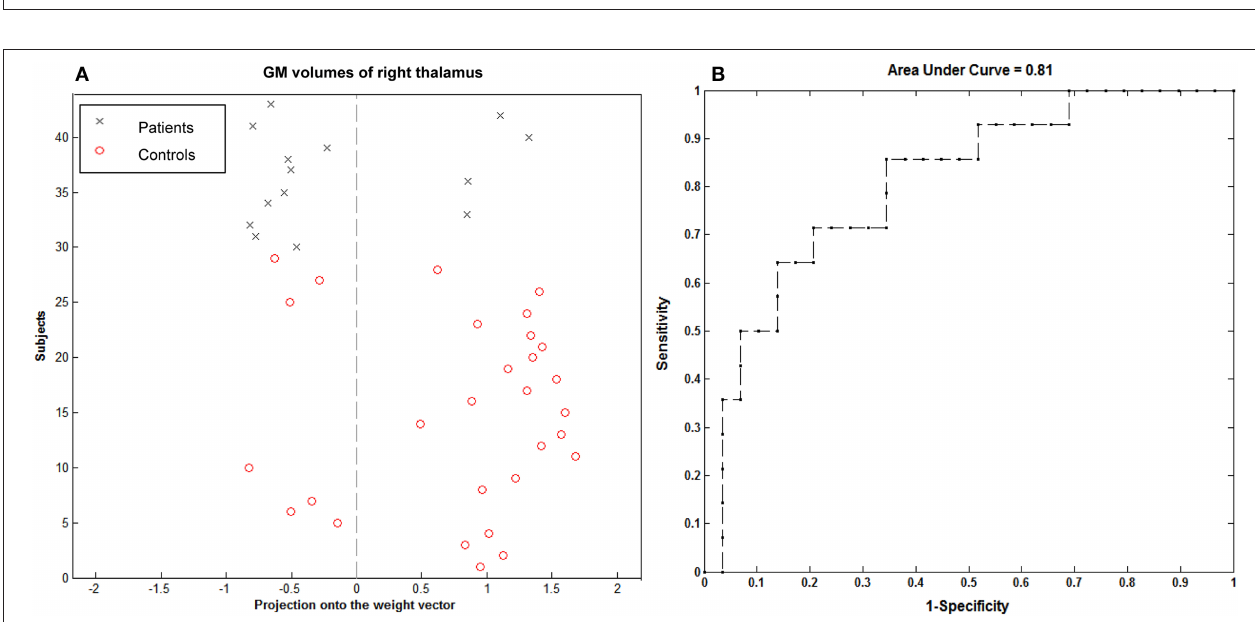
FIGURE 5 | Significant correlation between the fALFF and epilepsy duration. (Left) panel showed the location of the clusters with significant correlation in both model imaging. (Right) panel showed the scatter plots and the direction between the normalized fALFF of right hippocampus/thalamus and epilepsy duration.